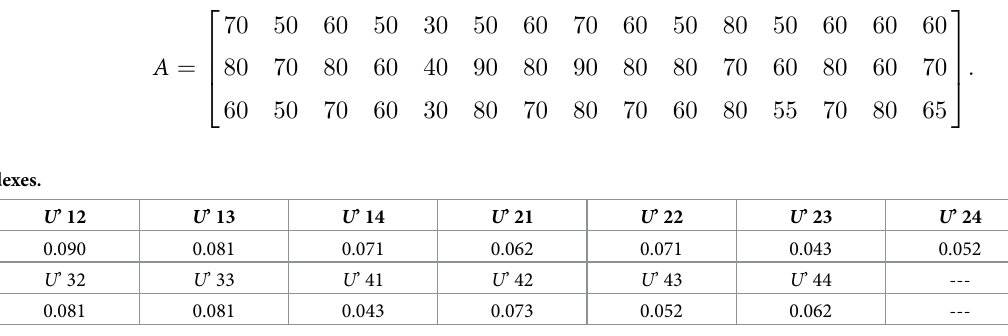
Considering the evaluation score from the experts on the dynamic changes in the spontane-